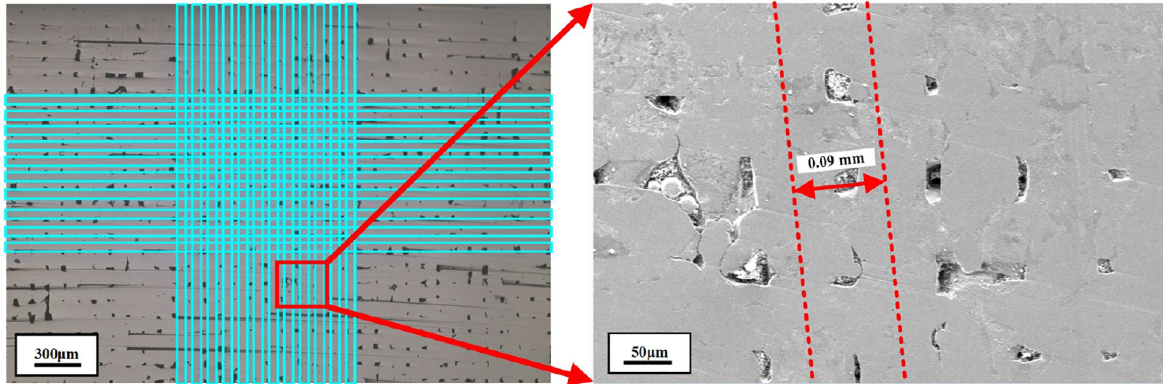
Figure 6 The surface morphology at the scan distance of 0.09 mm